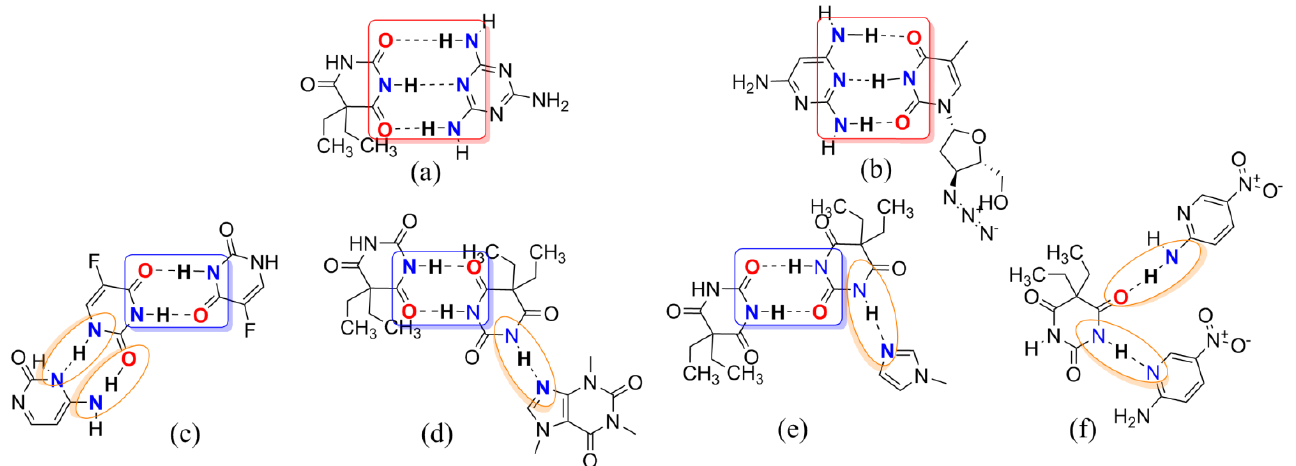
Figure 2 . Several examples of multicomponent chemical structures: ( a ) gliclazide metformin; ( b ) amino-methaniminium(butylcarbamoyl)(4-methylbenzene-1-sulfonyl)azanide; metformin acesulfame;